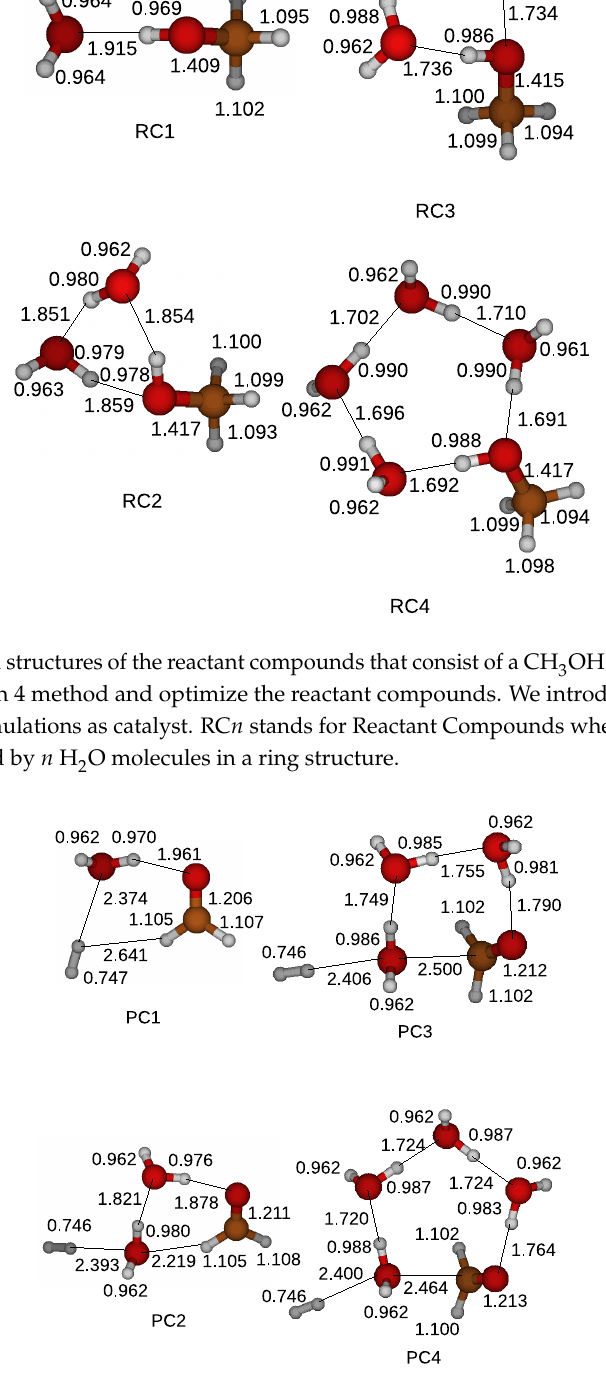
Figure 6. Optimized structures of the product compounds for the oxidation of a CH Gaussian 4 method and optimize the product compounds. PC n stands for Product Compounds when the oxidation of a CH OH is catalyzed by n H O molecules in a ring structure. 3 2 We apply the transition state theory to calculate the oxidation rate of a CH The oxidation rate of a CH OH is strongly dependent on the energy barrier for the 3